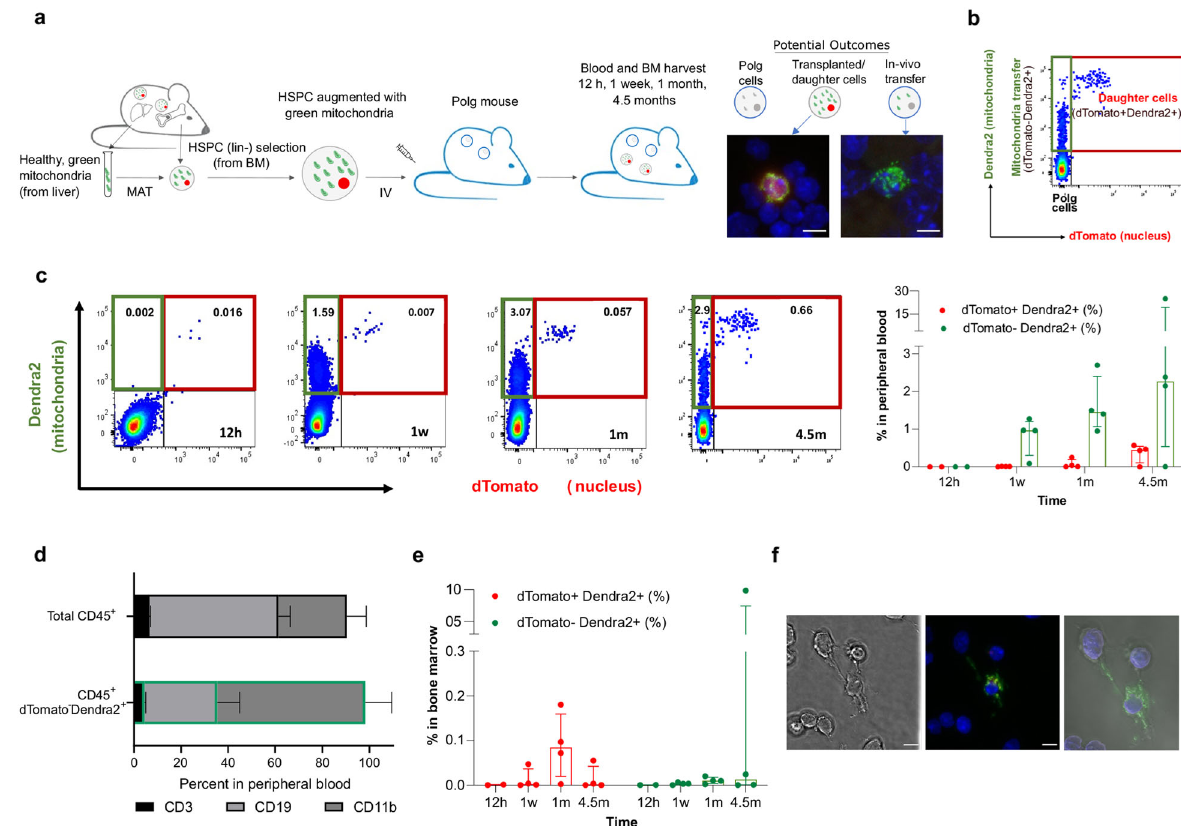
Fig. 4 Demonstration of continuous transfer of exogenous mitochondria in blood of Polg mouse model. Lineage negative cells ubiquitously expressing red-labeled nucleus (dTomato) and green-labeled mitochondria (Dendra) derived from ROSA nT-nG /PhAM excised mice were augmented with Dendra2 + mitochondria for 21 h and injected to Polg mice dosed at age 24 – 27 weeks (males) and 30-34 weeks (females). At 12 h, 1 w, 1 m, and 4.5 m post-injection blood was drawn and BM was extracted and both were analyzed by fl ow cytometry and confocal microscopy. a Graphical presentation of experimental design and a representative image of confocal microscopy of dTomato + Dendra2 + (left) and dTomato - Dendra2 + (right) found in bone marrow 1 m post-injection. Scale bar 5 µm. b Representation of fl ow cytometry analysis, which is expected to detect three types of cells: Polg cells, transplanted/daughter cells (red box, dTomato + Dendra2 + ) and Polg cells which received mitochondrial transfer (green box, dTomato - Dendra2 + ). c Representative fi gure of fl ow cytometry analysis of dTomato-Dendra2 + cells within CD45 + cell population in peripheral blood 12 h, 1 w, 1 m and 4.5 m post-injection (left). Percentages of dTomato + Dendra2 + cells and dTomato - Dendra2 + cells in peripheral blood (right). d Percentages of CD3 + T cells, CD19 + B cells and CD11b + myeloid cells within the CD45 + and dTomato - Dendra2 + populations in peripheral blood 1 m post-treatment. e Percentages of dTomato + Dendra2 + cells (left) and dTomato - Dendra2 + cells (right) in the bone marrow. f Representative image of confocal microscopy analysis of BM extracted cells at 4.5 months after treatment, demonstrating Dendra2 + mitochondria transfer between adjacent cells. Left, differential interference contrast (DIC); center, merged fl orescent image from DAPI, Dendra2 and dTomato channels. Scale bar, 5 µm; right, 3D reconstruction of the Z-stack images. BM bone marrow, HSPCs hematopoietic stem and progenitor